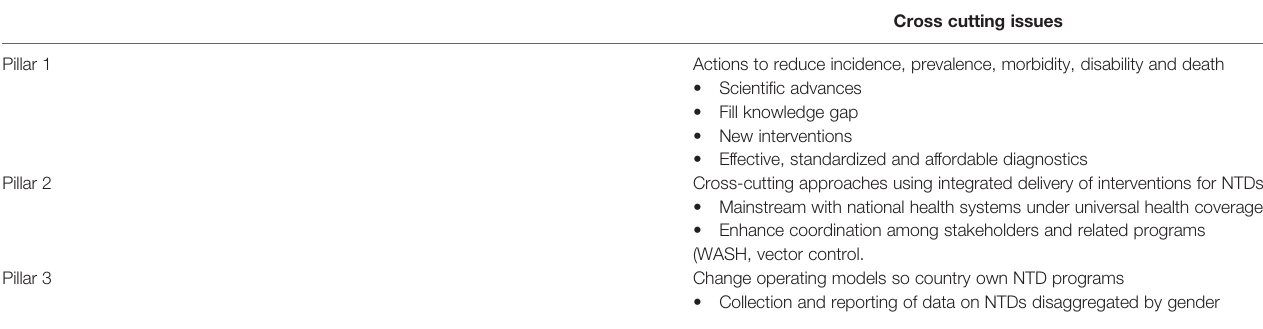
TABLE 1 | Cross-cutting activities for WHO roadmap